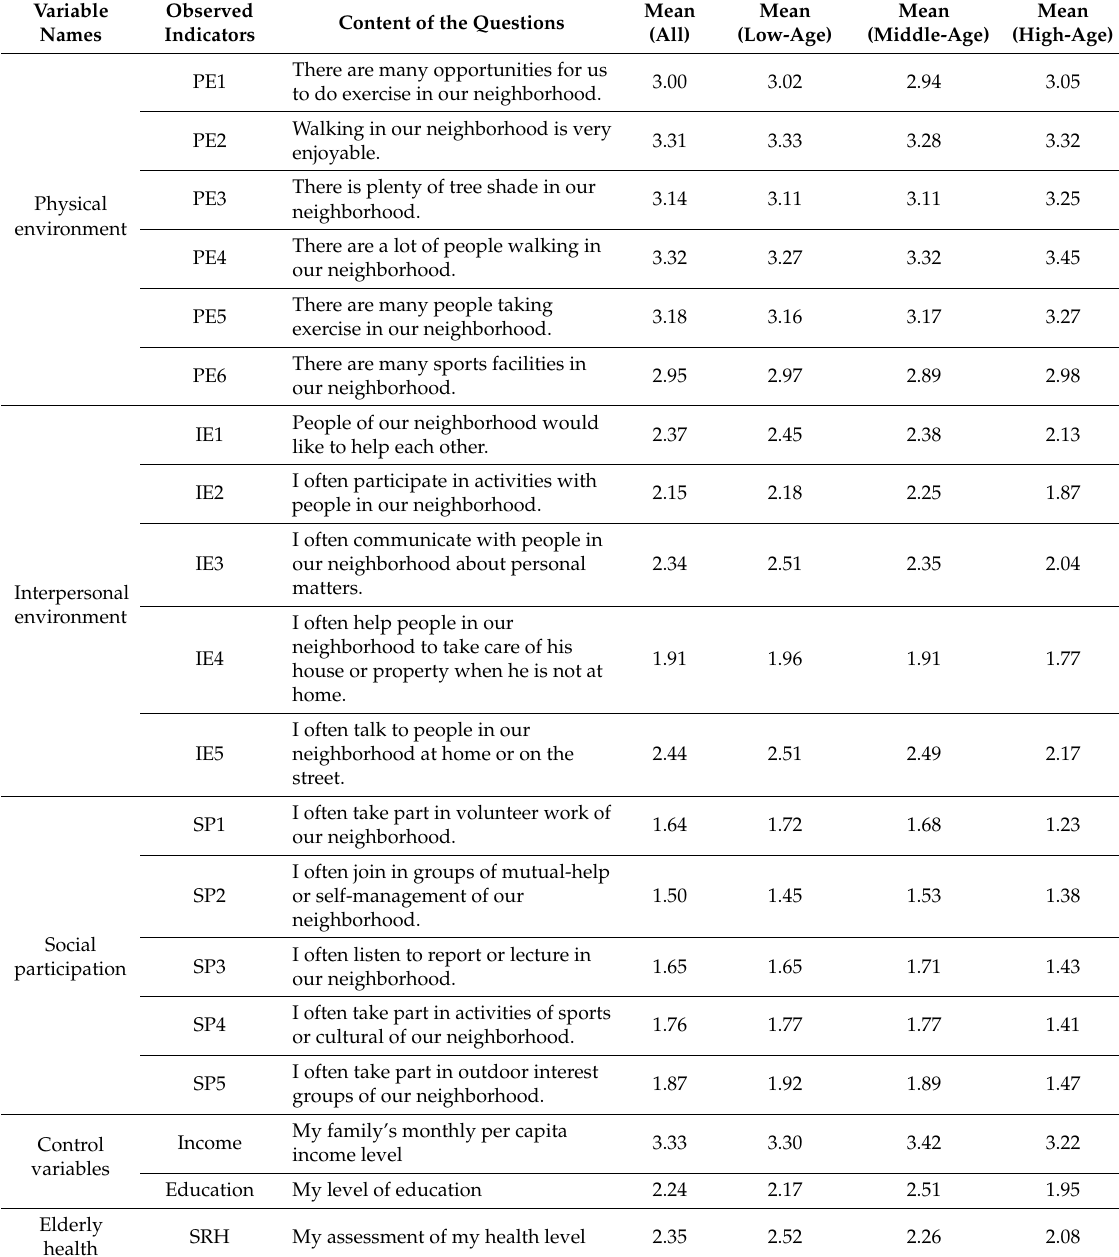
Table 2. Description of main